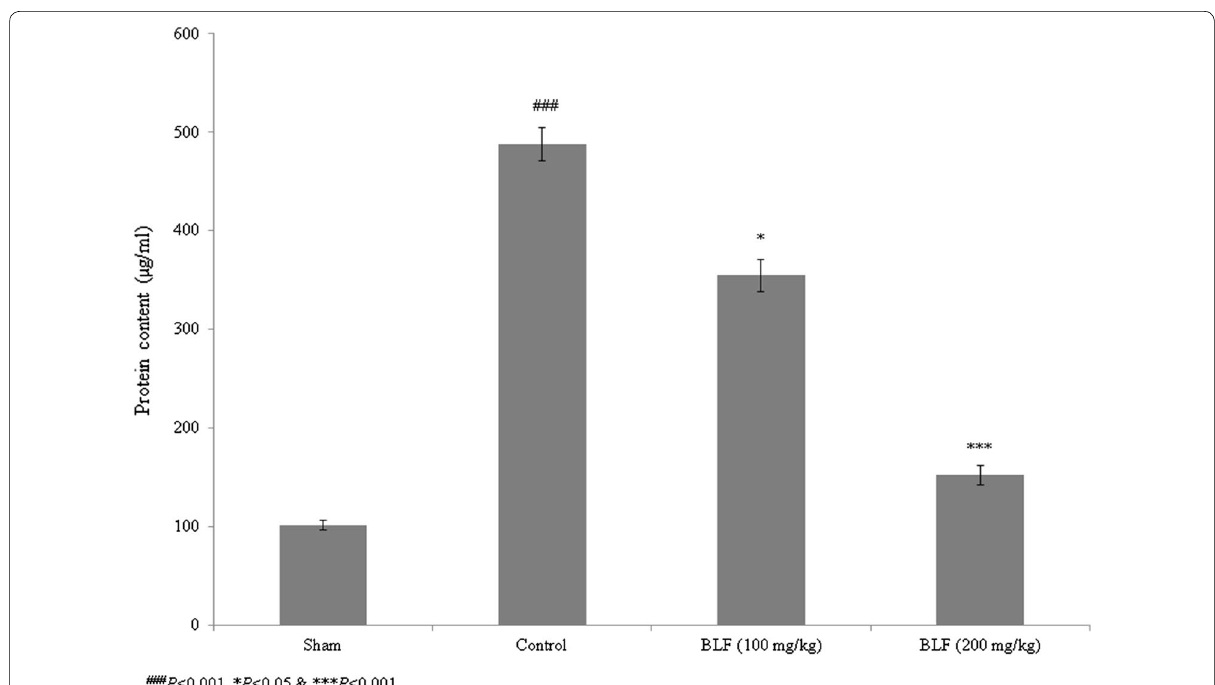
Fig. 4 BLF reduces total protein content in the lung tissue homogenate of ALI-induced male albino rats. Rats were given BLF for 30 consecutive days through oral gavage. ### P < 0.001 compared to the sham group; * P < 0.05 and *** P < 0.001 compared to control rats